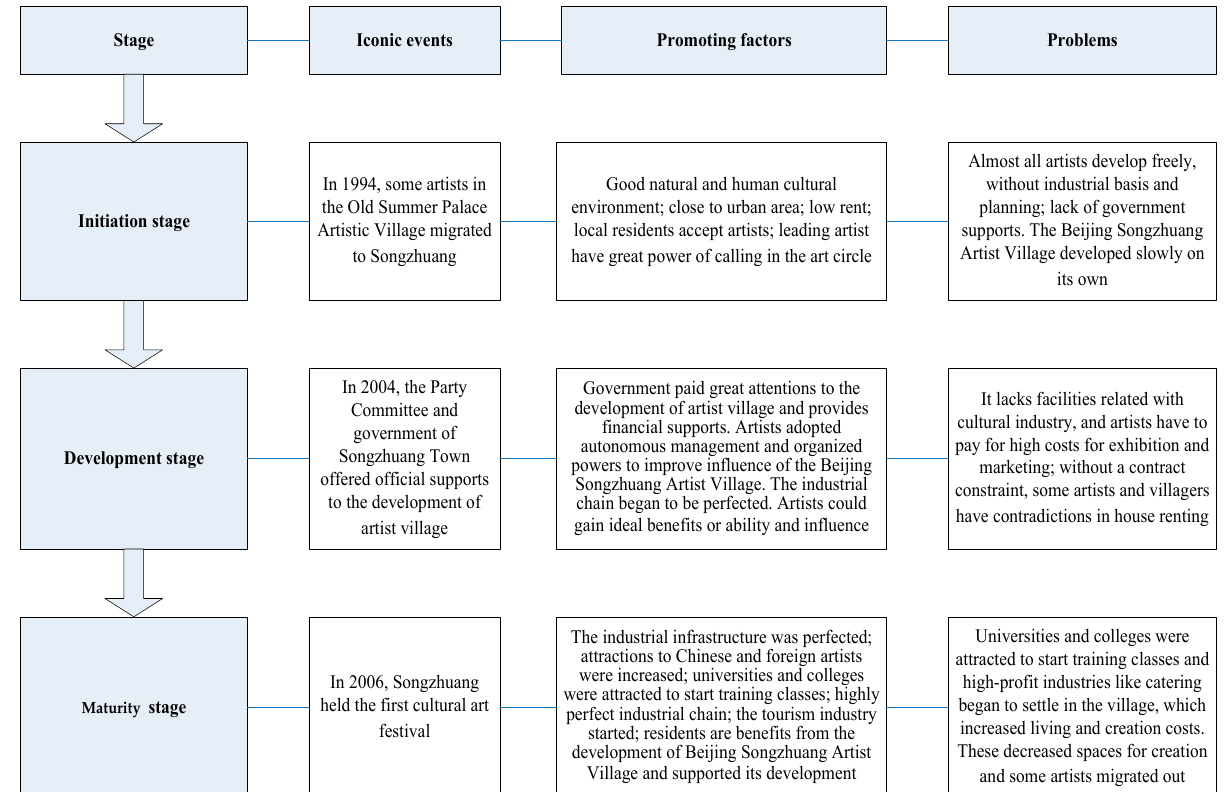
Figure 5. Development path of Beijing Songzhuang Artist Village.